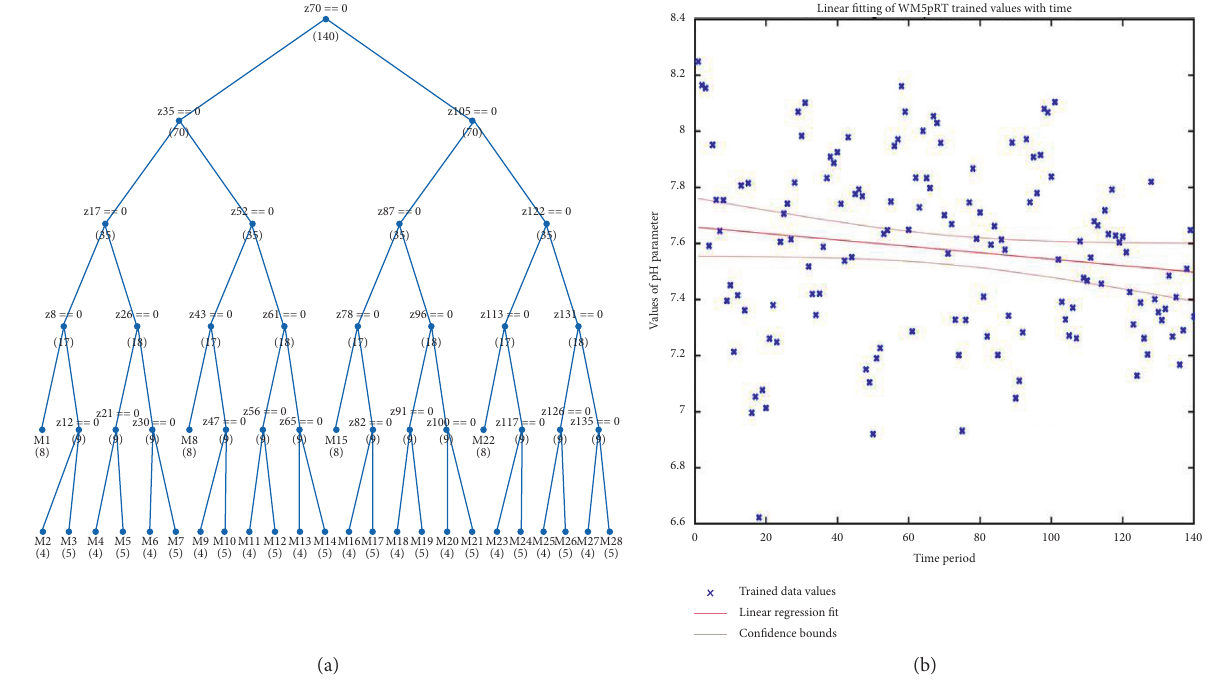
Figure 16: (a) WM5p regression tree of pH values at Bridge. (b) Linear regression fit of WM5pRT trained pH values at Table 3: Various studies using different intelligent models.